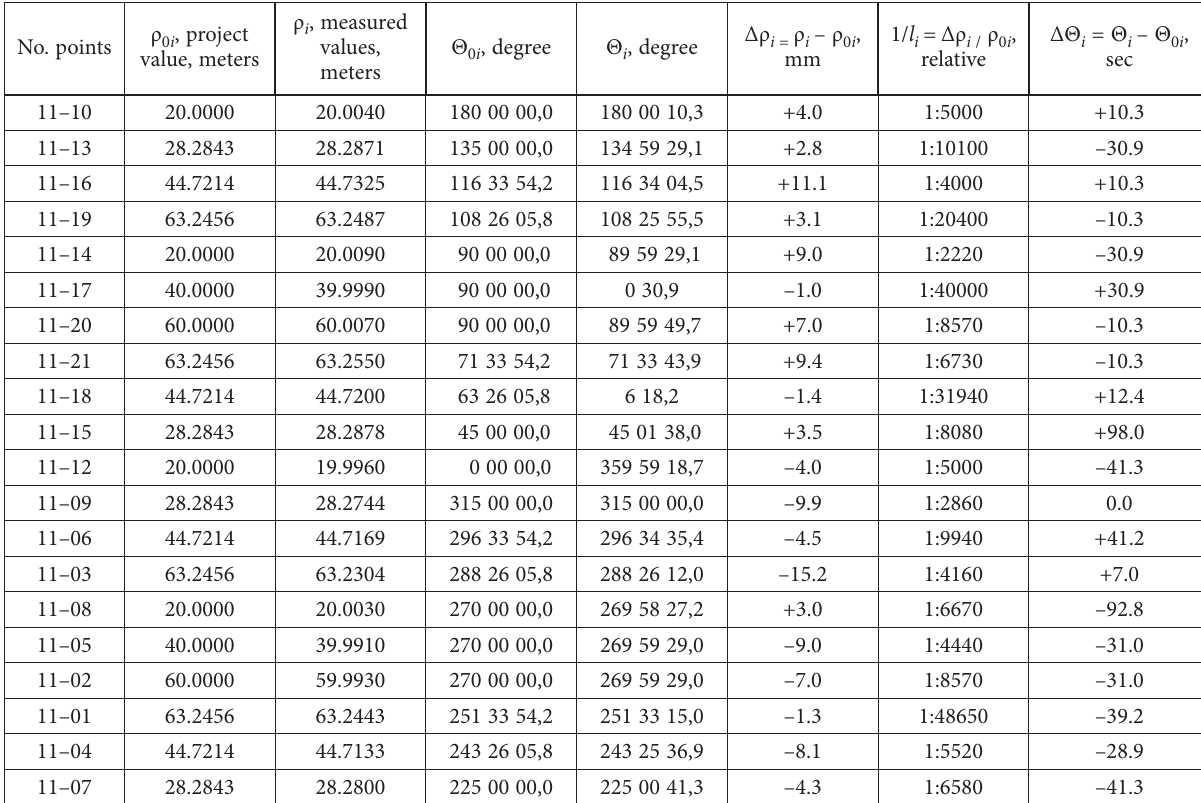
Table 1. Relative and angular deformation of equipment points No.